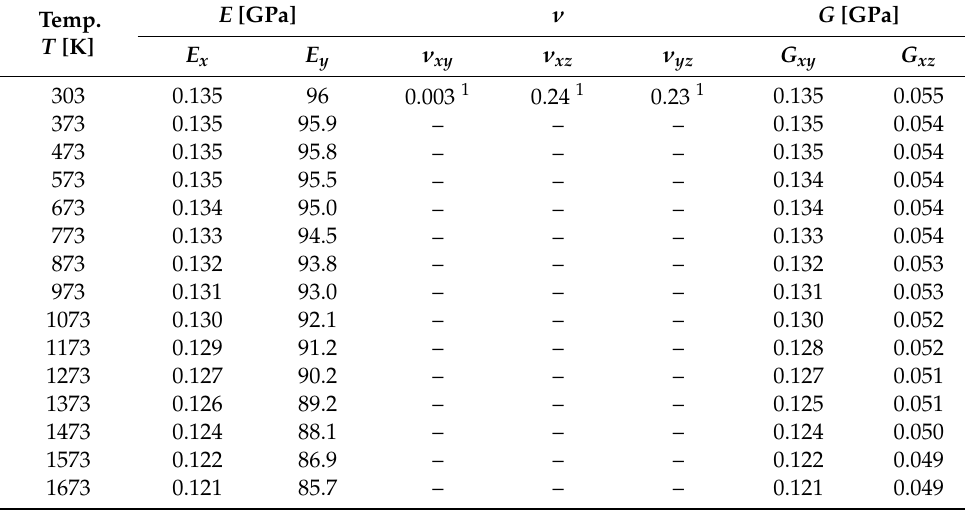
Table 6. Elastic properties ( E , ν , and G ) of YbMS anisotropic homogenous layer. Temp.